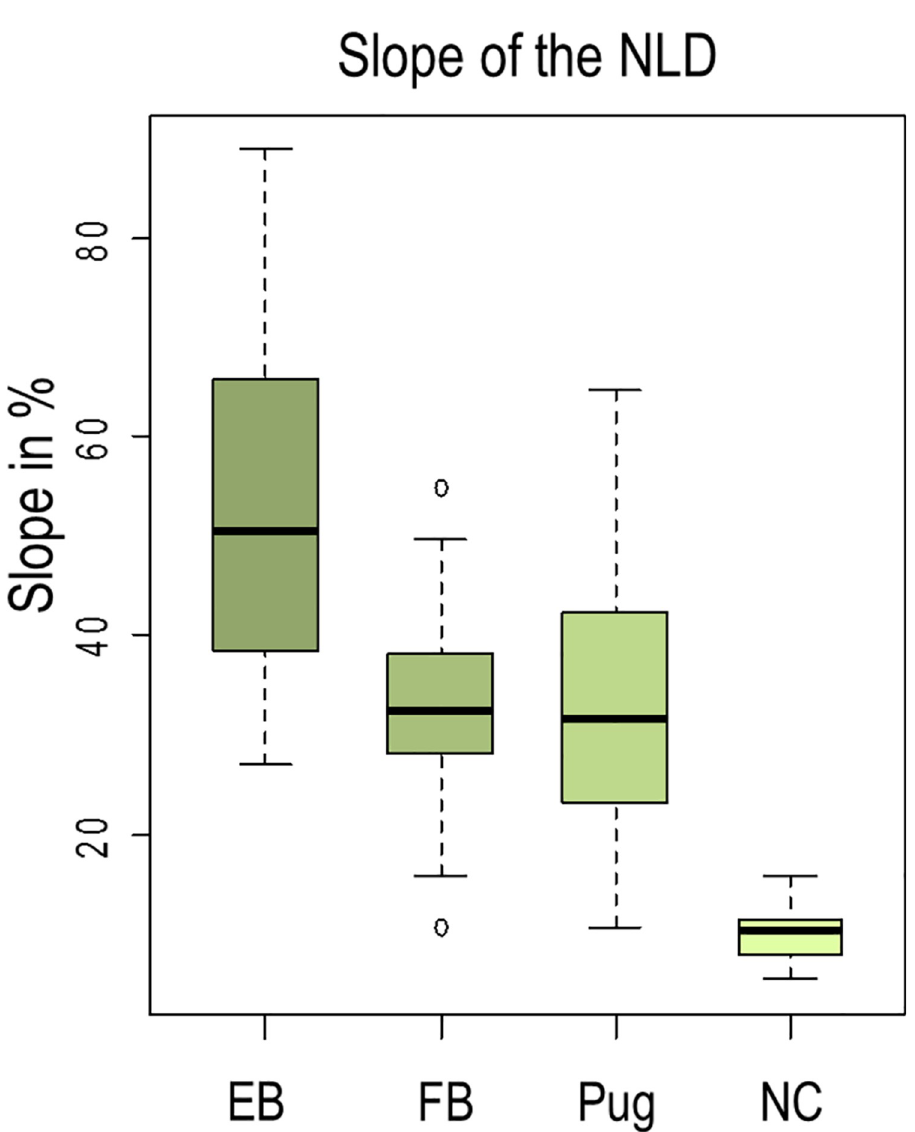
Fig 5. Gradient of the nasolacrimal duct (NLD). The slope in percent of the NLD in 10 English Bulldogs (EB), 18 French Bulldogs (FB), 20 Pugs, and six normocephalic dogs (NC) presented in a box-and-whisker